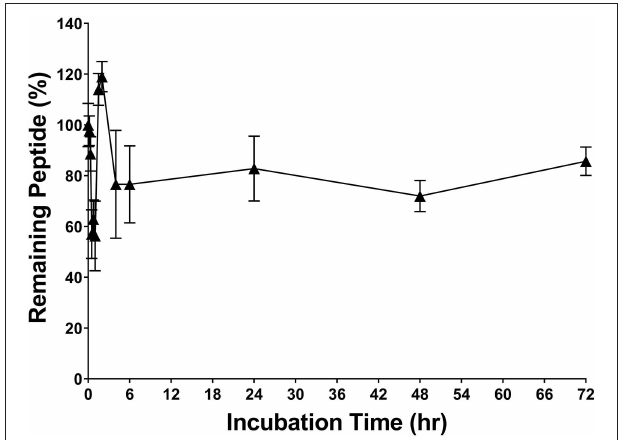
FIGURE 2 | RP557 is stable in serum. RP557, at 200 µ g/mL, was incubated with human serum for 72h at 37 ◦ C and peptide monitored via LC-MS/MS. Data represent mean ± SE. Assays were performed in